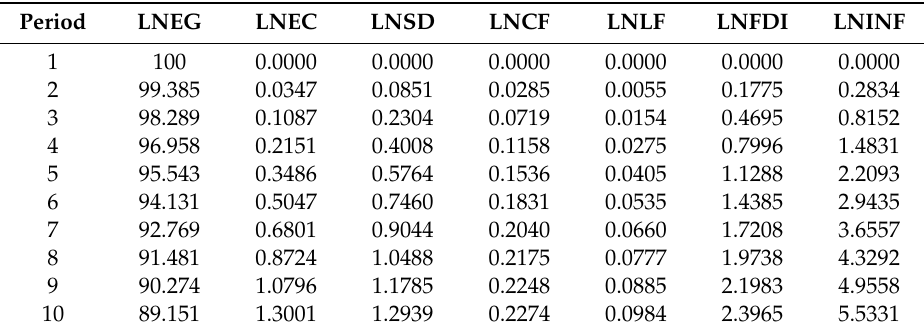
Table 8. Variance Decomposition Analysis for the Model 1